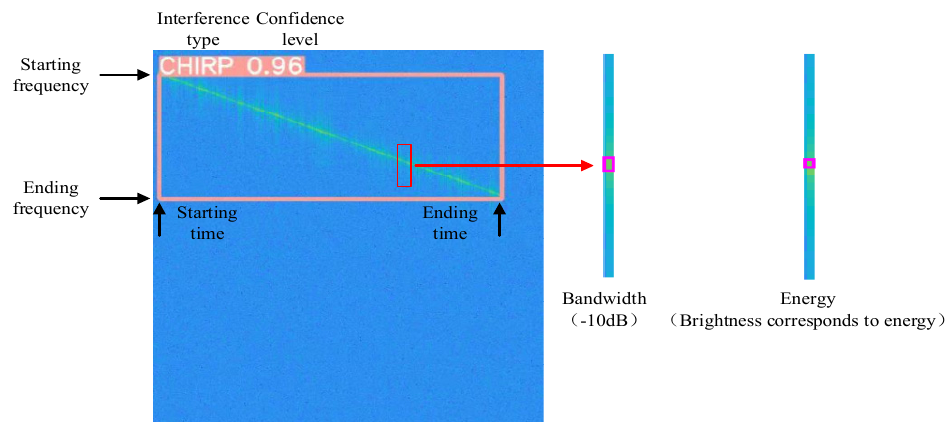
Figure 3. Time frequency image interference monitoring results.